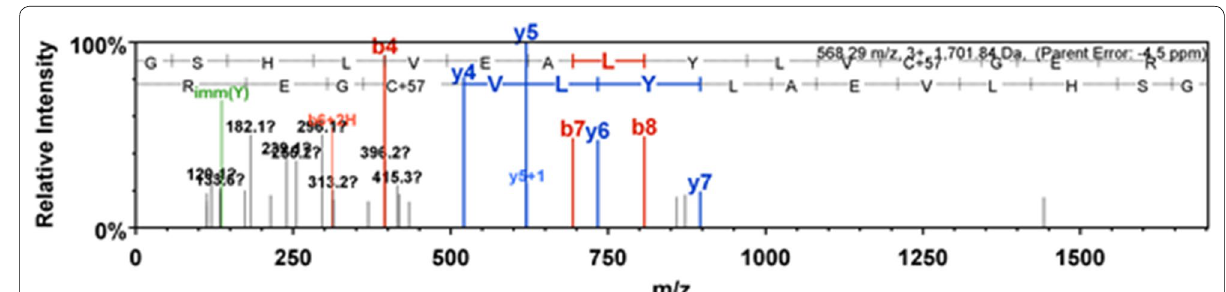
Fig. 3 A peptide spectrum illustrating the protein sequence of crude biosynthesised human insulin, which was a 100% match to the human insulin sequence derived from the Scaffold 1.4.4